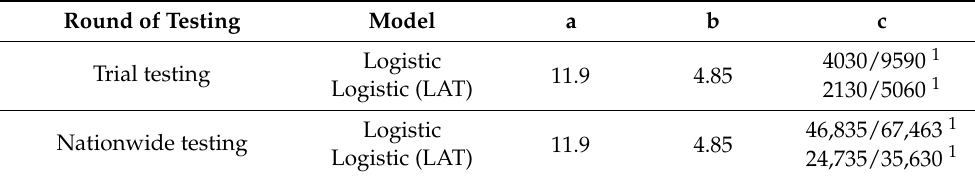
Table 4. The coefficients table for the logistic